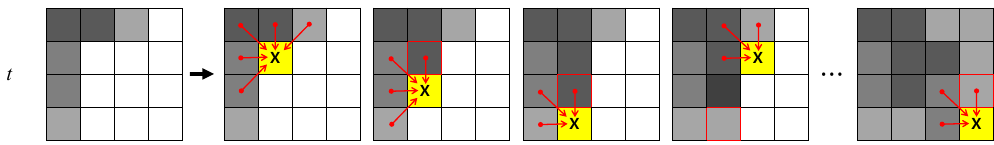
Figure 9. Cell evolution step by ACA. The first column is the initial cell state at time t . (The yellow marker denoted as X indicates the current defender and the red arrow is the direction of attack by its neighboring cell, represented as the attacker. The rectangular areas in red indicate that the cell state has